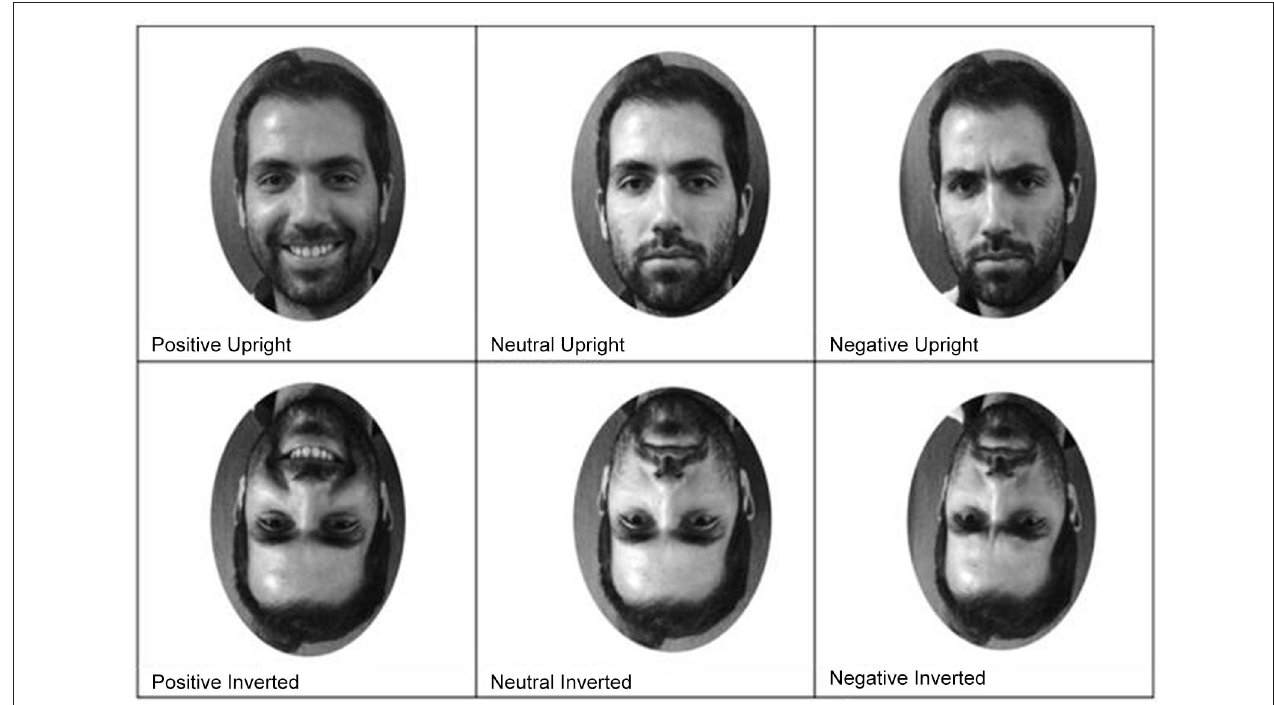
FIGURE 1 | Example of stimuli images